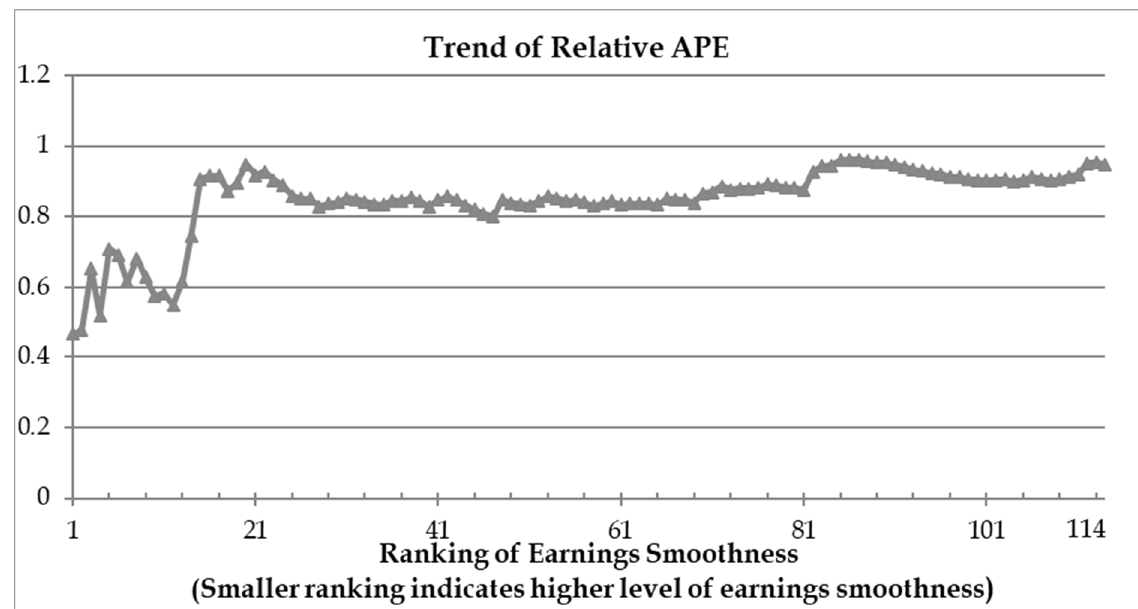
Figure 2. Earnings smoothness and the predictive gain from using quarterly